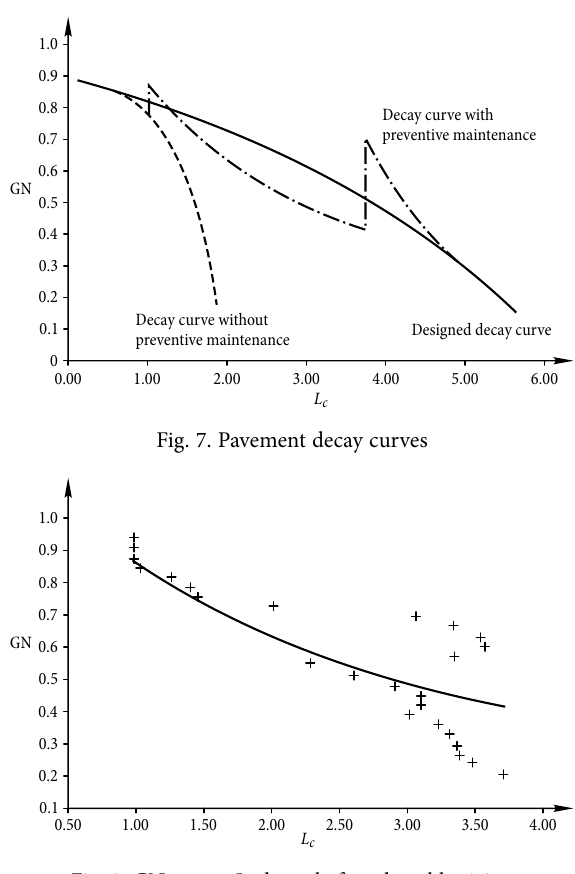
Fig. 8. GN versus L c decay before de-rubberizing